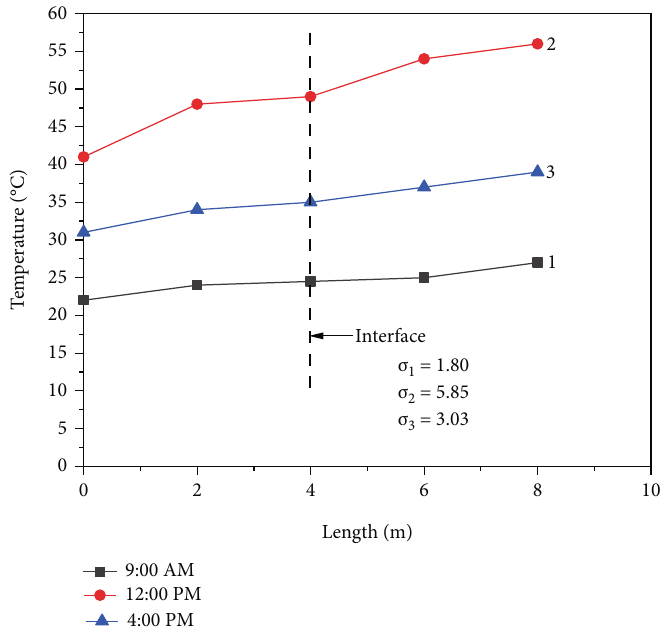
Figure 6: The temperature pro fi le along the length of the collector/dryer during unloading